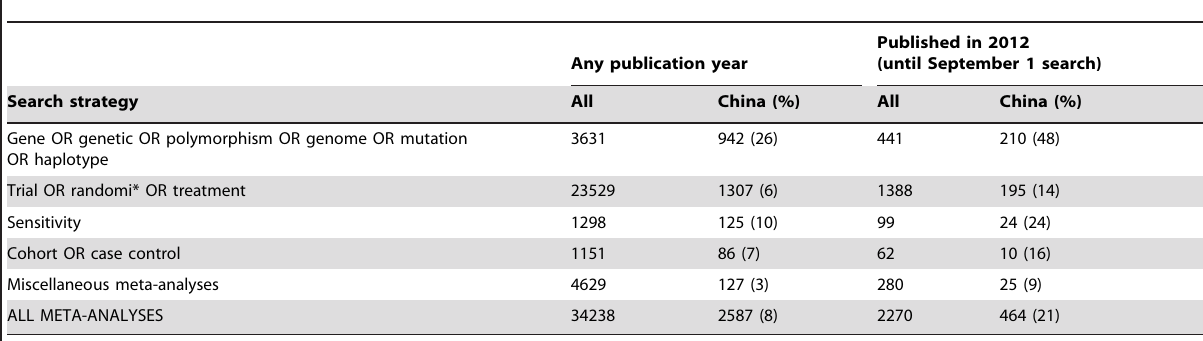
Table 2. Different Types of Meta-analyses Overall and from China.